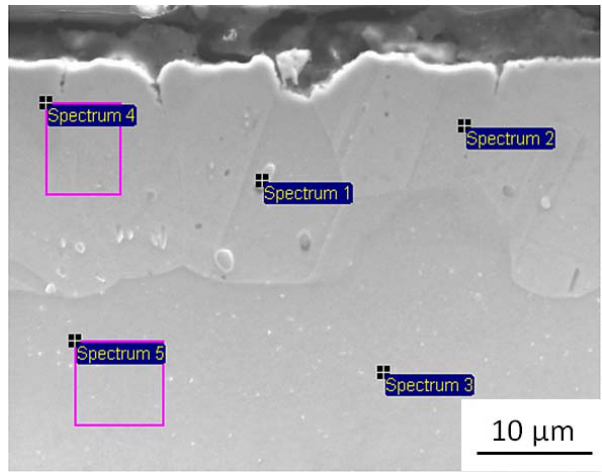
Figure 19. Locations of EDX analysis. SE imaging.